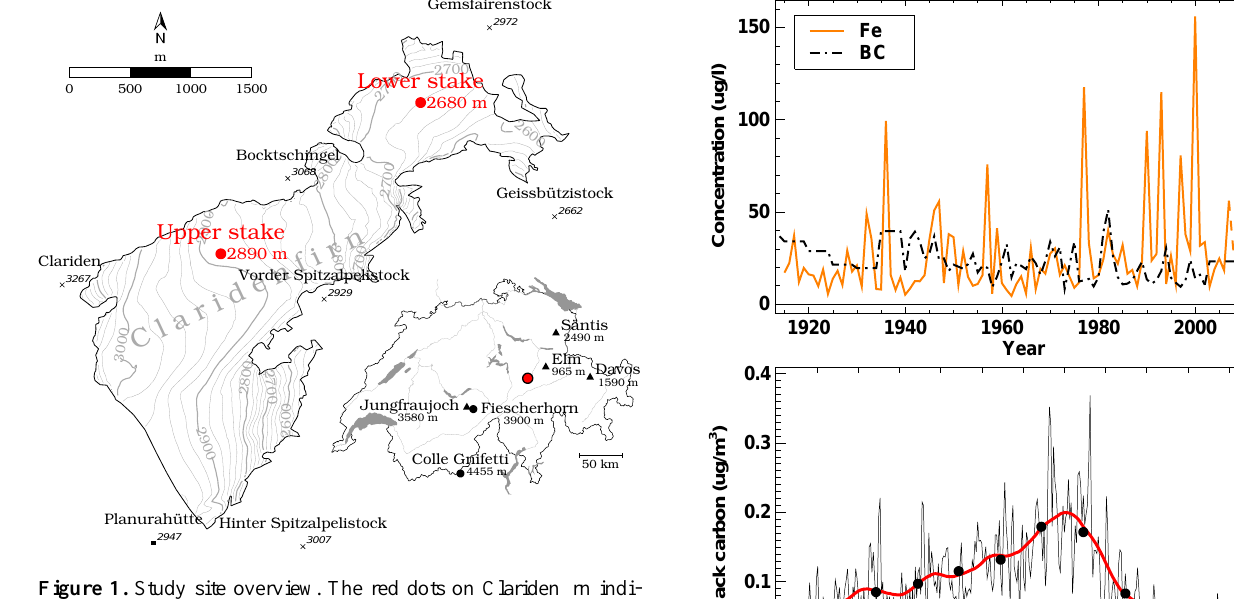
Figure 1. Study site overview. The red dots on Claridenfirn indi- cate the lower and the upper stake. The inset shows the location of the study site within Switzerland (red point), of the ice core sites Colle Gnifetti and Fiescherhorn (black dot). The aerosol measure- ment station Jungfraujoch and the weather stations used to derive meteorological time series (black triangles) are indicated.